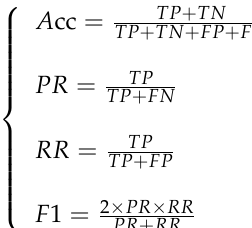
Figure 11. Datacon sample.